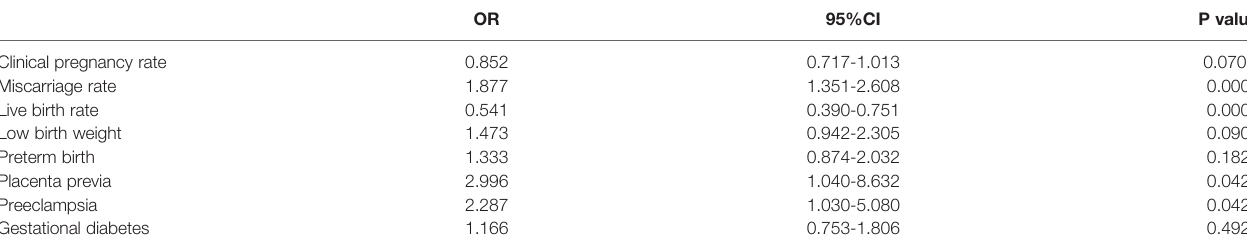
TABLE 4 | Comparison of clinical outcomes and obstetric complications between adenomyosis and control group.